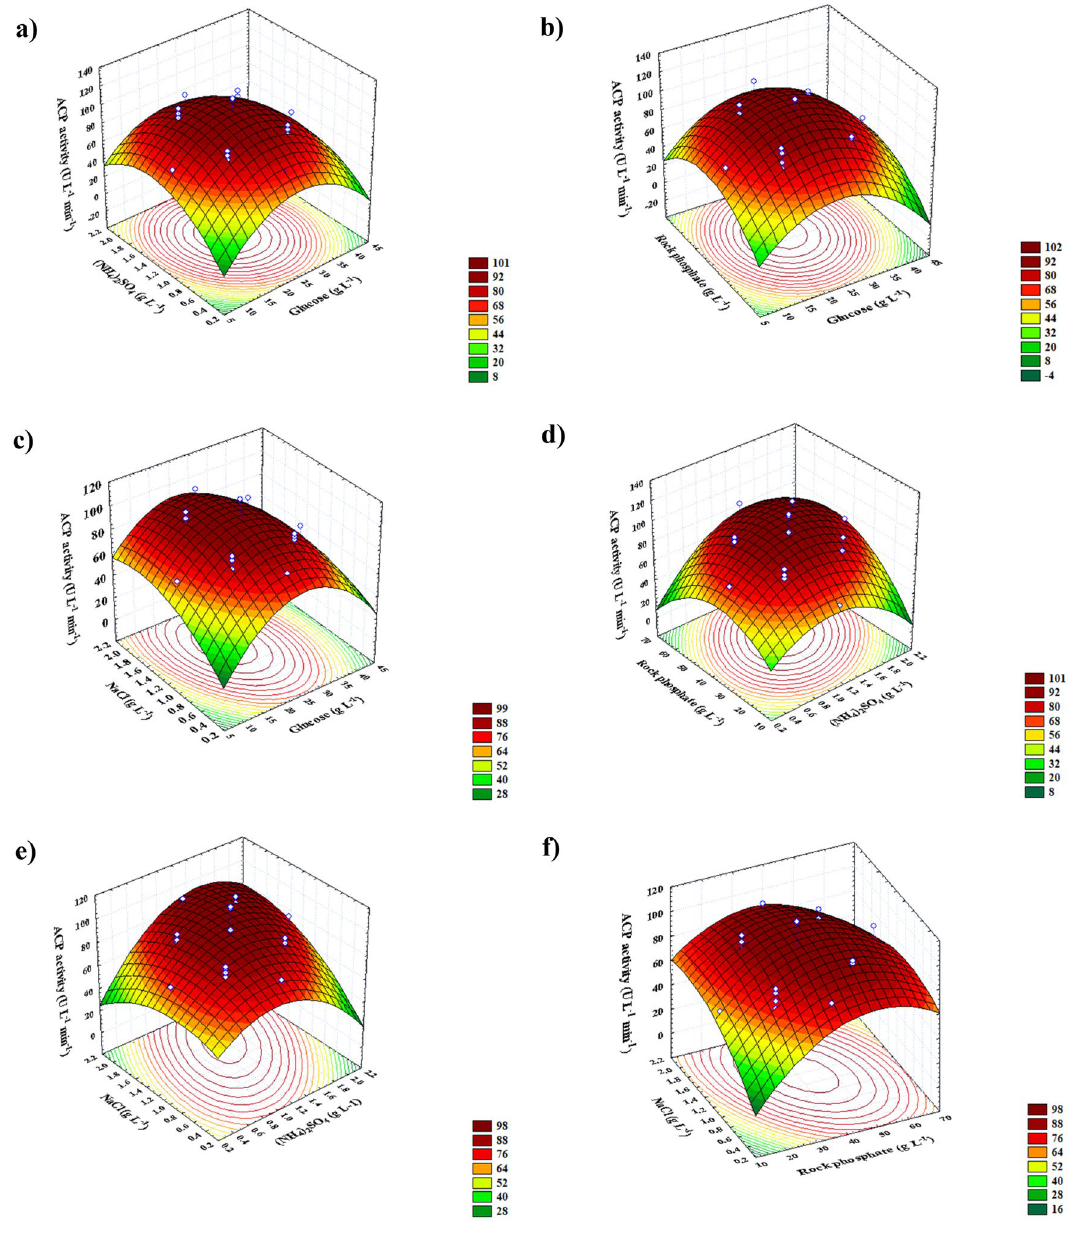
Figure 5. 3D response surface representing acid phosphatase activity yield (U L −1 min −1 ) from B. haynesii strain ACP1 as affected by culture conditions, (a) interaction between (NH 4 ) 2 SO 4 and glucose, (b) interaction between rock phosphate and glucose, (c) interaction between NaCl and glucose, (d) interaction between rock phosphate and (NH 4 ) 2 SO 4 , (e) interaction between NaCl and (NH 4 ) 2 SO 4 , and (f) interaction between NaCl and rock optimal predicted glucose (23.2 g L −1 ) and (NH 4 ) 2 SO 4 (1.3117 g L −1 ) concentrations at RP and NaCl concentra- tions of 37.5 and 1.2 g L −1 , respectively. Moreover, according to Fig. 5b, RP levels ( X 3 ) at lower and higher levels are associated with a reduction in ACP activity. However, the highest ACP activity (115.67 U L −1 ) is located close to both glucose ( X 1 ) and RP’s central point ( X 3 ). This emphasizes the roles of glucose ( X 1 ) and RP ( X 3 ) in ACP biosynthesis. A similar trend of ACP efficiency was observed for the other pairwise combination of variables under consideration. In Fig. 5c, ACP production reached its peak (115.36 U L −1 ) when NaCl ( X 4 ) was increased to 1.3 g L −1 and at the center point of glucose ( X 1 ), while the two other variable variables remained at zero. It was noticed that when using (NH 4 ) 2 SO 4 ( X 2 ) and RP ( X 3 ) at middle concentrations, as indicated in Fig. 5d, the maximum throughput of ACP was reached (115.95 U L −1 ); any further increase or decrease was followed with a loss in the productivity of the ACP. Whilst maintaining glucose ( X 1 ) and RP ( X 3 ) at their zero levels, raising NaCl concentration slightly beyond its center point enhanced ACP productiveness (115.63 U L −1 ) when (NH 4 ) 2 SO 4